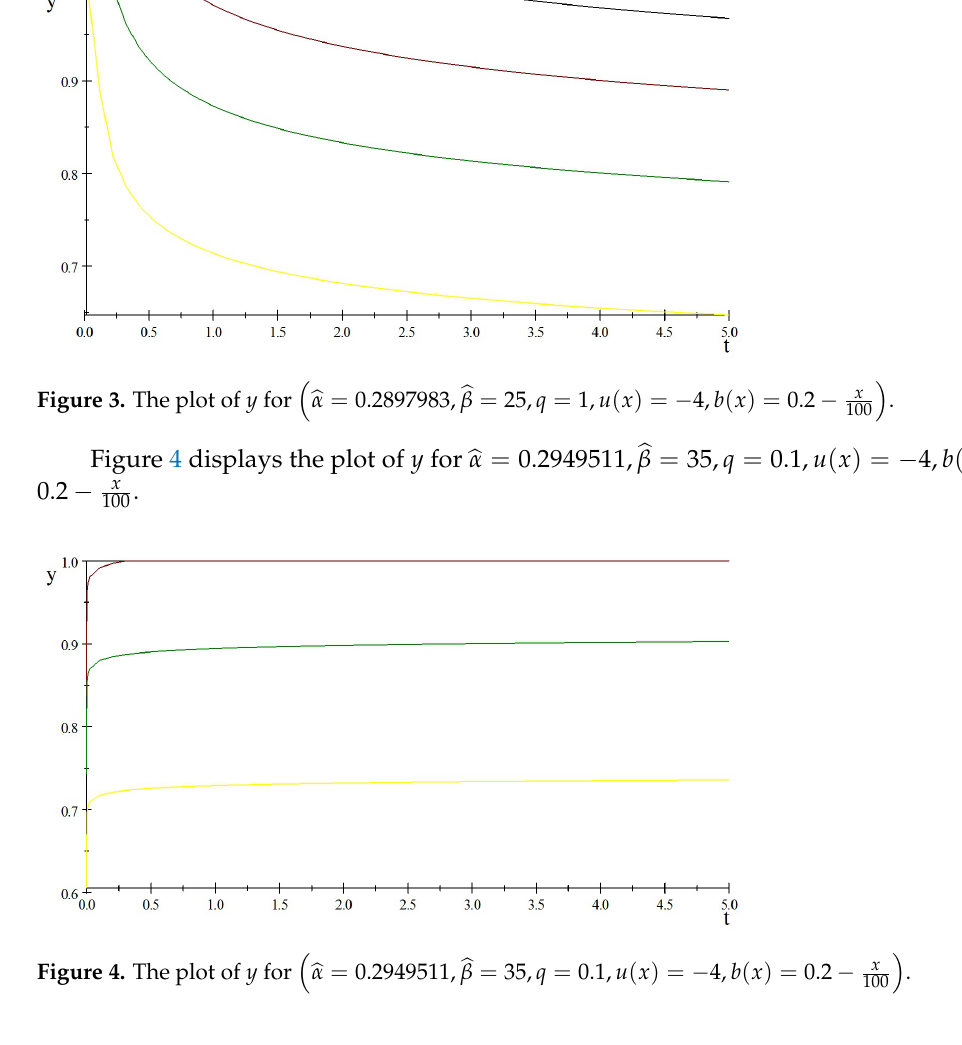
Figure 4. The plot of y for